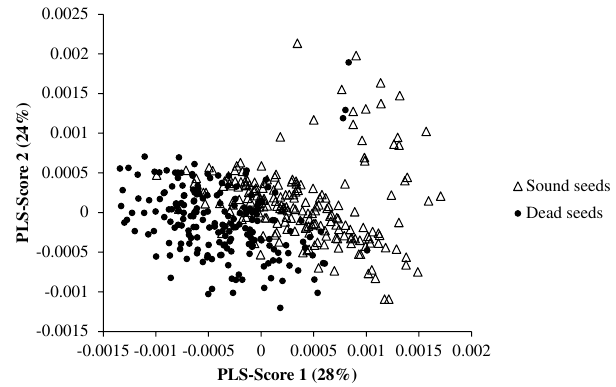
Fig. 6. PLS score plot of score 1 versus score 2 showing two mostly separated clusters of sound mung bean seeds and dead mung bean seeds.